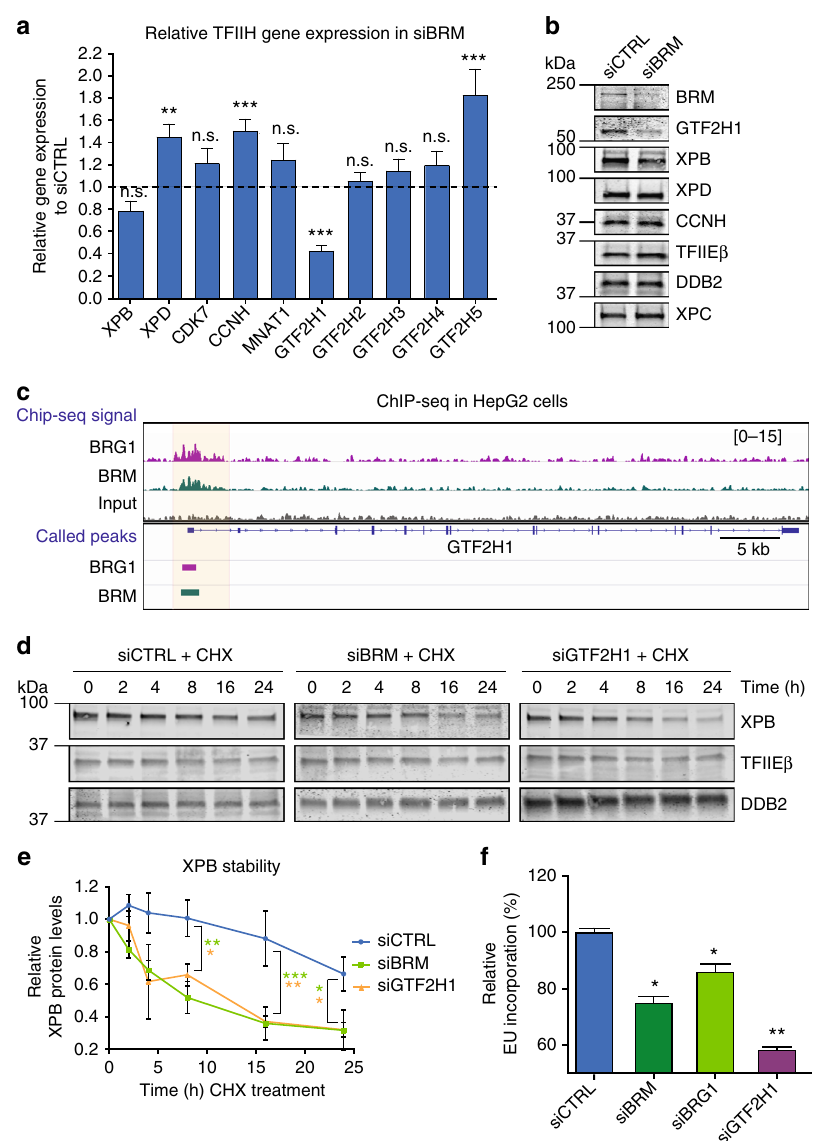
Fig. 3 BRM stabilizes TFIIH by promoting GTF2H1 expression. a Relative quanti fi cation of individual TFIIH genes expression in U2OS cells treated with control (CTRL) or BRM siRNAs, as determined with RT-qPCR. Individual basal gene expression in BRM knockdown was normalized to siCTRL levels, which were set to 1.0 (dotted line in graph). GAPDH expression was used for normalization. Mean & S.E.M. of at least three independent experiments. ** P < 0.01, *** P < 0.001 relative expression in each gene to siCTRL. n.s., non-signi fi cant. b Immunoblot analysis of TFIIH protein levels (GTF2H1, XPB, XPD, CCNH), TFIIE β , DDB2 and XPC from whole cell extracts of U2OS treated with control (CTRL) or BRM siRNAs. Representative immunoblots of two independent experiments. c BRG1 and BRM co-occupancy of GTF2H1 promotor. Re-analysis of published ChIP-seq data in which ChIP-seq signal density (top) and respective peaks (bottom) illustrate BRG1 (purple) and BRM (green) enrichment at the promoter of GTF2H1 in HepG2 cells (upon shNS transfection 32 ). Promoter region of interest highlighted in light orange, signal density in reads per million. d XPB protein stability was evaluated in U2OS cells treated with control (CTRL) or BRM siRNAs at different time points after addition of 100 µ M cycloheximide (CHX) to inhibit protein synthesis. Immunostainings of TFIIE β and DDB2 were used as negative and loading controls, respectively. e Quanti fi cation of XPB protein levels normalized to DDB2 in time after addition of CHX. The total amount of XPB in whole cell lysates was set to 1.0 at t = 0. Mean & S.E.M. of at least three independent experiments. * P < 0.05, ** P < 0.01, *** P < 0.001 for each time point of siBRM (green) or siGTF2H1 (orange) relative to siCTRL. f Relative quanti fi cation of transcription levels in U2OS cells treated with non-targeting control (CTRL), BRM, BRG1, or GTF2H1 siRNAs. Transcription was determined by measuring EU incorporation in non- irradiated cells 48 h after siRNA treatment. EU relative fl uorescence intensity was set to 100% in siCTRL treated cells. Mean & S.E.M. of > 200 cells from two (siGT2H1) and three (siBRM and siBRG1) independent experiments. Full-size immunoblot scans are provided in Supplementary Fig. 6b,